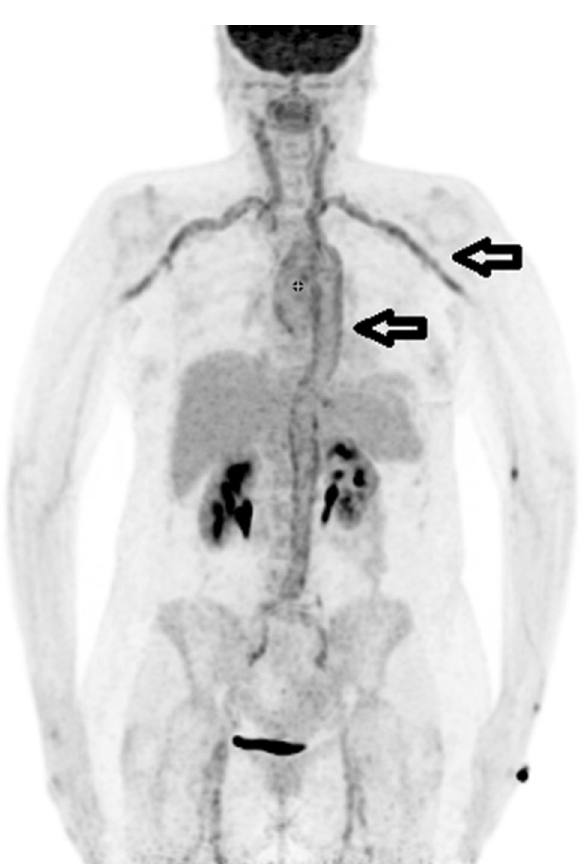
Figure 2. Patient no. 43, 68-year-old female, met the FUO criteria. F-18 FDG PET/CT torso imaging shows longitudinal uptake along the aorta and the large vessels, pathognomonic for giant cell arteritis (arrows). Patient showed only minimal clinical symptoms for vasculitis. Causal anti-inflammatory therapy with oral cortisone was started to which patient responded